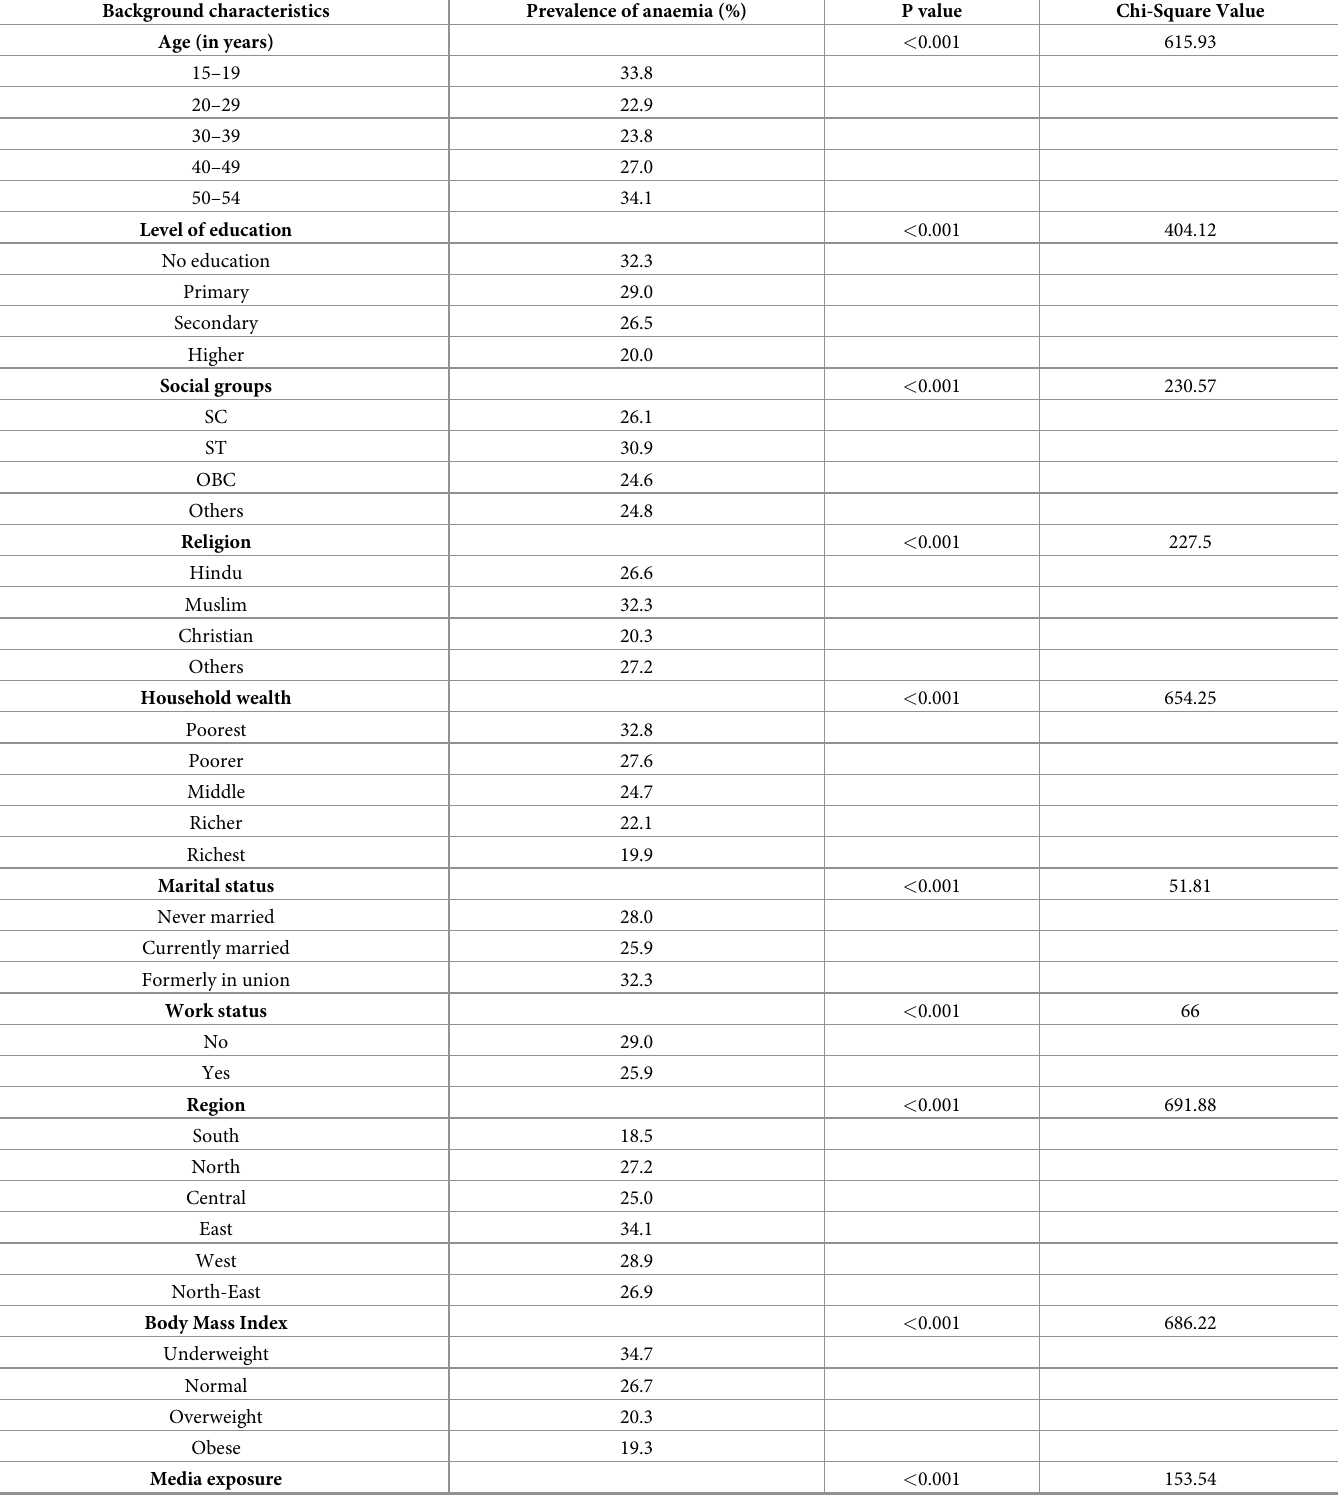
Table 3. Differentials in the prevalence of anaemia among rural men by background characteristics, India, 2019–21. Background